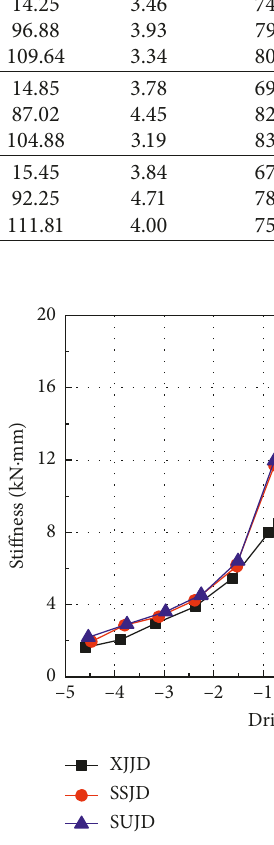
Figure 14: Stiffness attenuation curves of the specimens. Table 10: Ductility coefficients of the